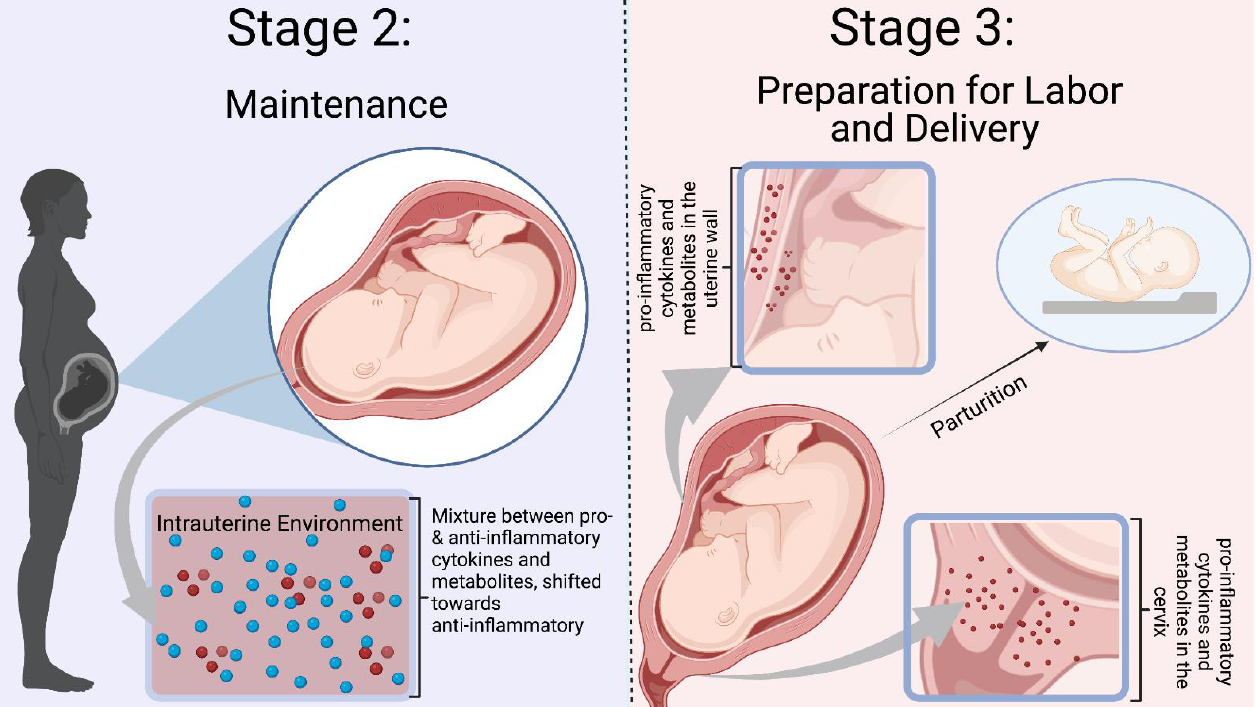
Figure 3. Mor et al. Stages 2 – 3 of Immunological Events Occurring During Pregnancy. Stage 2 is defined by a balance between pro- and anti-inflammatory mediators, with a shift towards an anti-inflammatory environment. Inflammation is needed to prevent infection and rejection of the fetus. Stage 3 is a pro-inflammatory state with preparation for labor and delivery. Cytokines and mediators remodel the cervix and infiltrate the uterus to participate in uterine contractions [10]. The blue dots represent ant-inflammatory molecules, and the red dots represent pro-inflammatory molecules. Figure was created in Biorender.